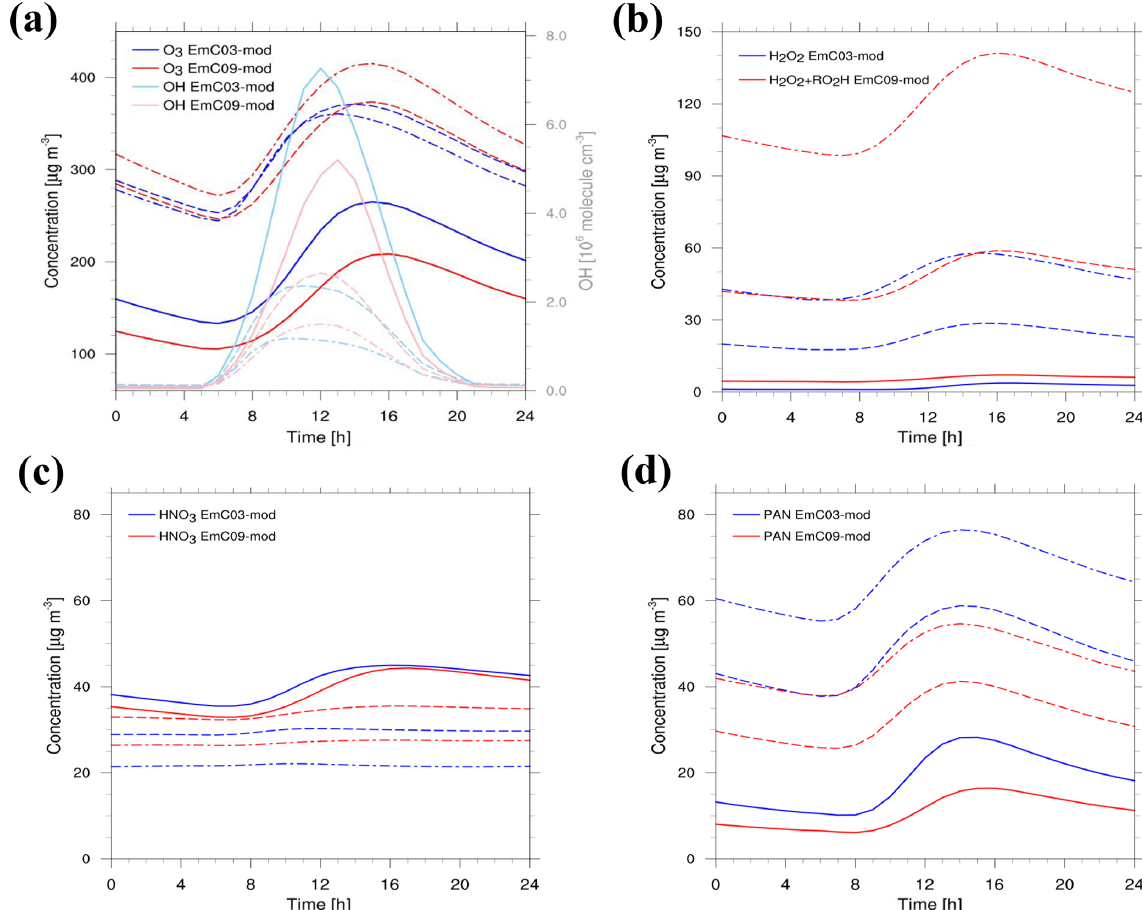
Figure 3. Comparison of EmChem09-mod (red lines) with EmChem03-mod (blue lines) for three different VOC / NO x ratios: (a) O 3 and OH (light colours, second y axis); (b) H 2 O 2 and organic peroxides (abbreviated as RO 2 H); (c) HNO 3 ; and (d) PAN. Daily concentration cycle as an average from a test run with NO x emissions of 4 . 3 × 10 − 8 gs − 1 m − 2 and NMVOC emissions corresponding to a VOC / NO x ratio of 4:1 (solid lines), 8:1 (dashed lines) and 15:1 (dash-dotted lines).